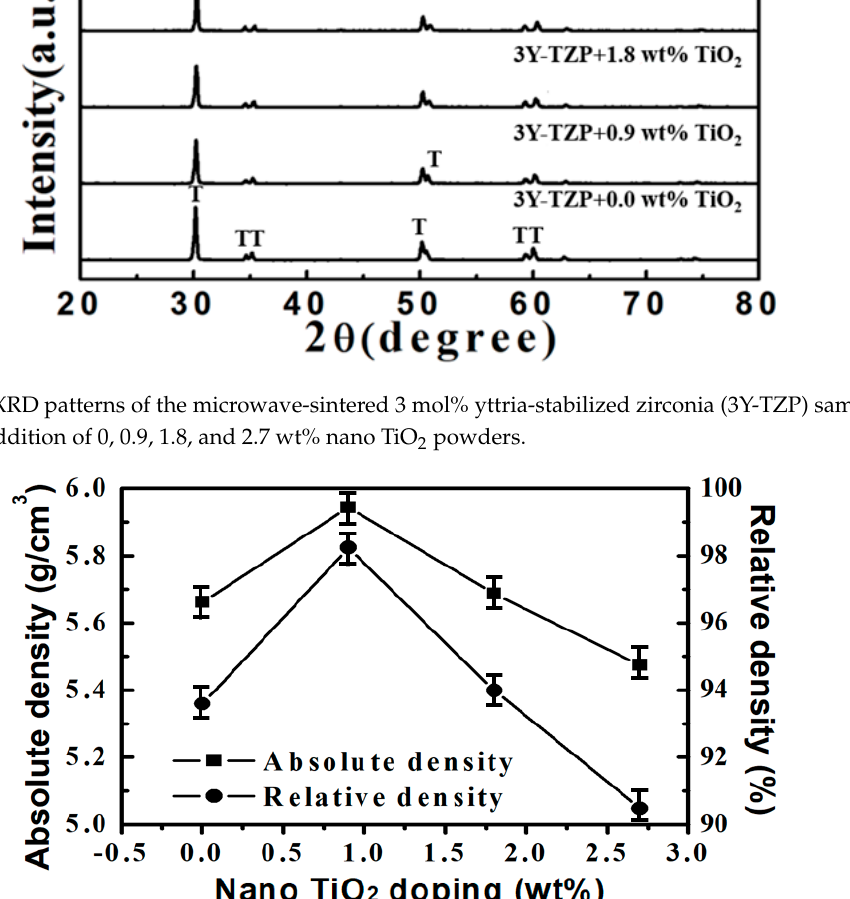
Figure 1. XRD patterns of the microwave-sintered 3 mol% yttria-stabilized zirconia (3Y-TZP) samples with the addition of 0, 0.9, 1.8, and 2.7 wt% nano TiO 2 powders.